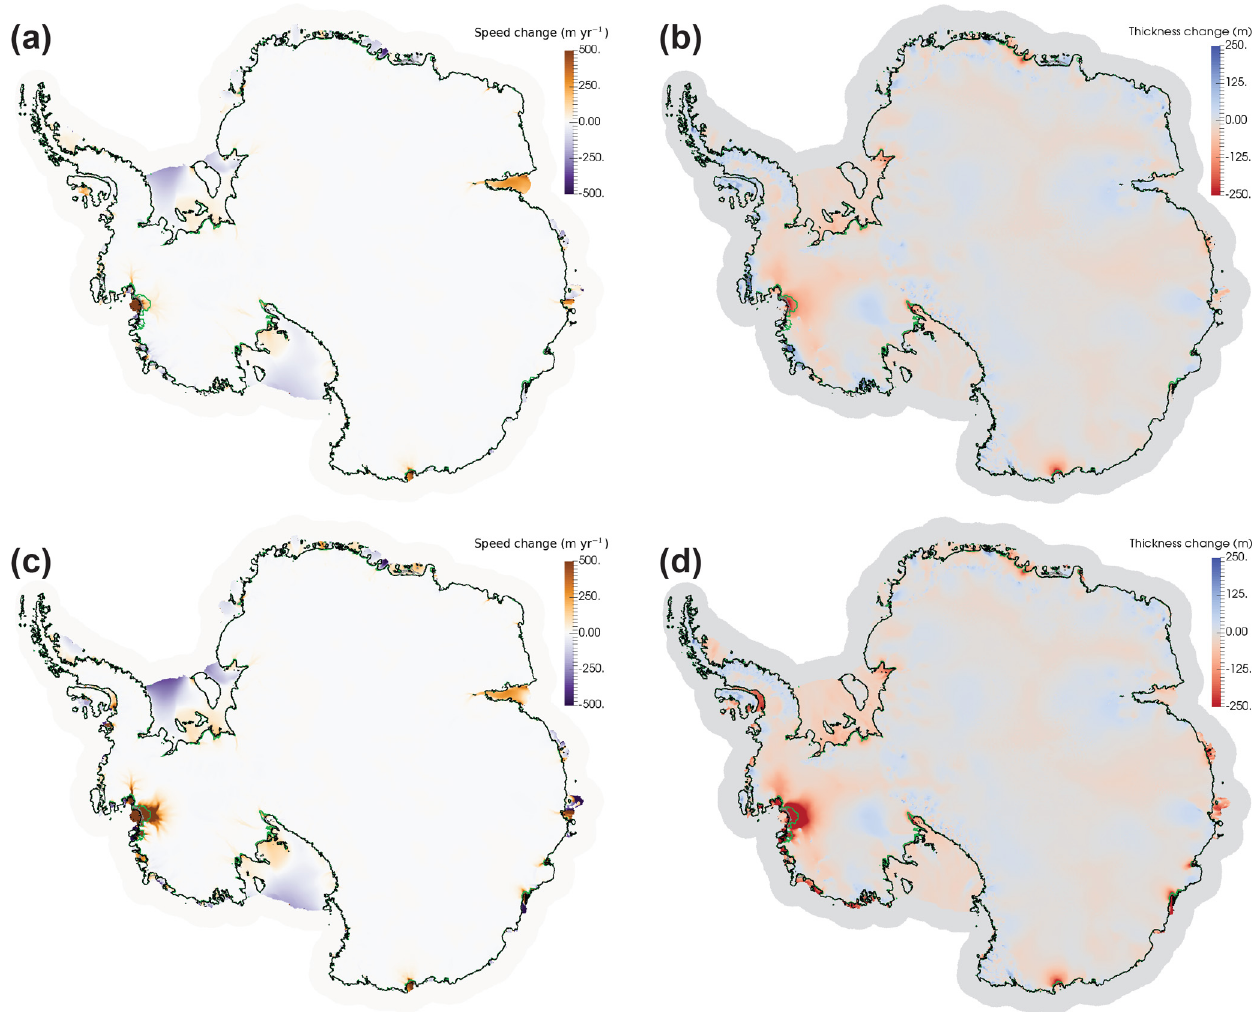
Figure 13. Speed and thickness change during 100-year initMIP simulations. (a) Change in surface speed at 100 years relative to initial condition for control simulation. (b) Change in ice thickness at 100 years relative to initial condition for control simulation. (c) Change in surface speed at 100 years relative to initial condition for sub-ice-shelf melt perturbation simulation. (d) Change in ice thickness at 100 years relative to initial condition for sub-ice-shelf melt perturbation simulation. In all panels, the black line indicates the grounding line at the initial time, the gray line is the grounding line at year 100 in the control simulation, and the green line is the grounding line at year 100 in the sub-ice-shelf melt perturbation